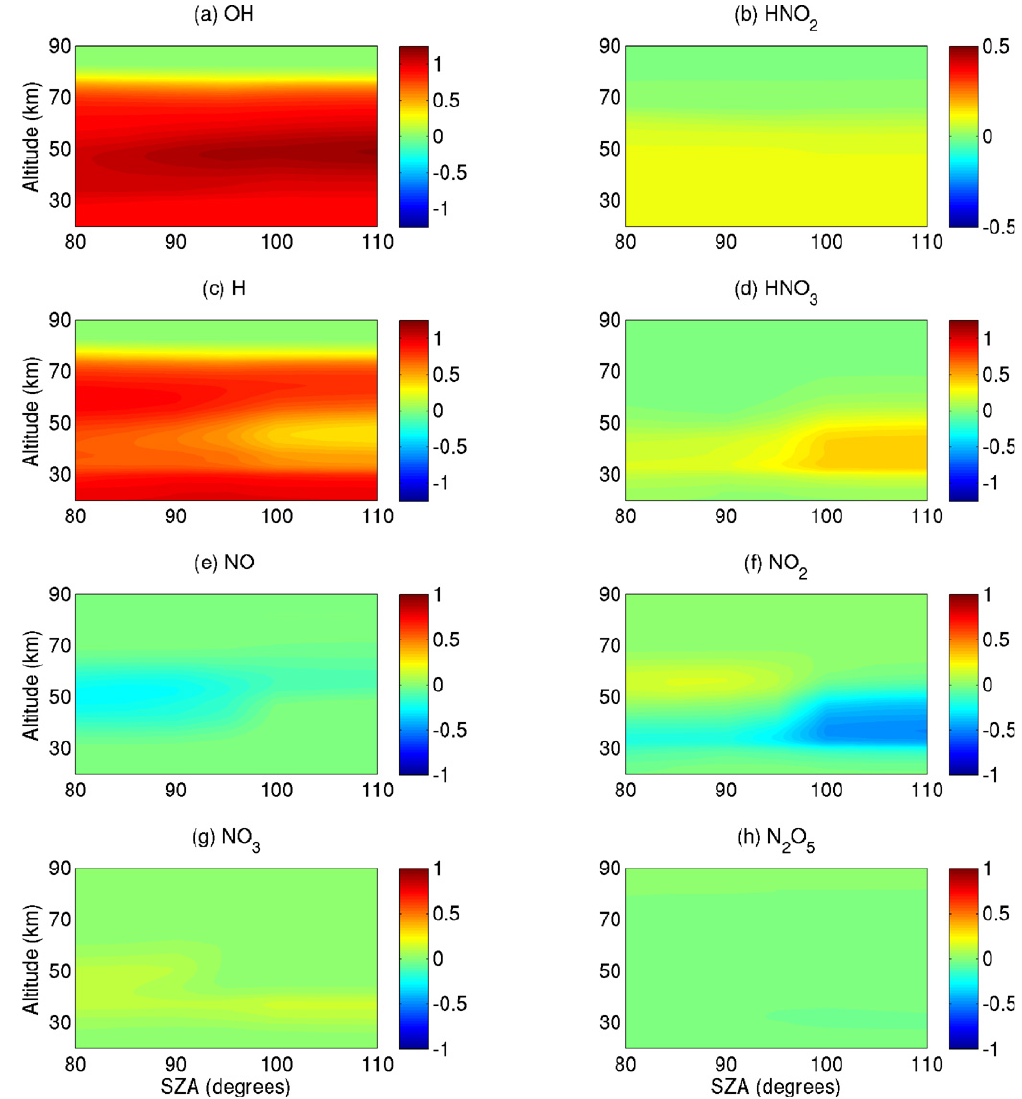
Fig. 3. As Fig. 2, but Q = 100000cm − 3 s − 1